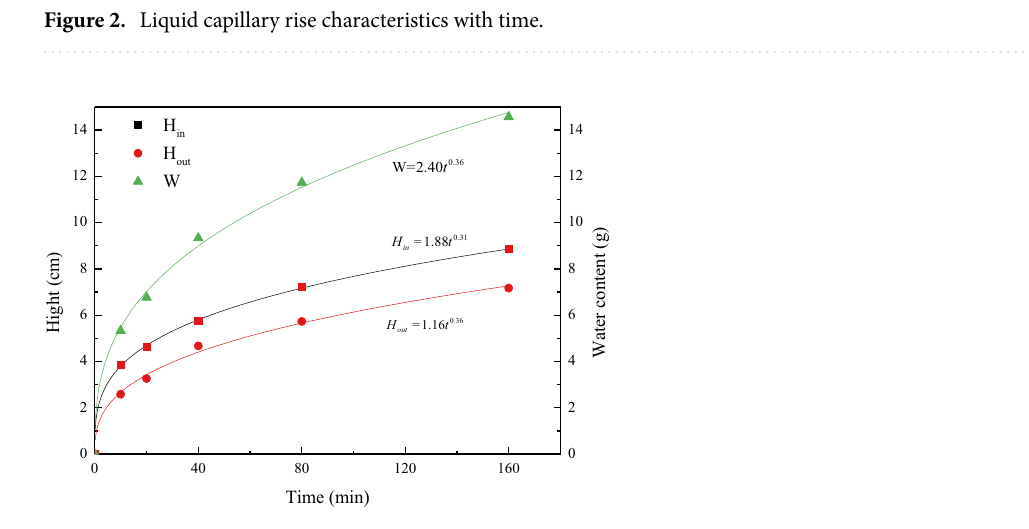
Figure 3. Evolution of capillary rise parameters with time: H in : height of the internal wetting surface, H out : height of the external wetting line, and W—water